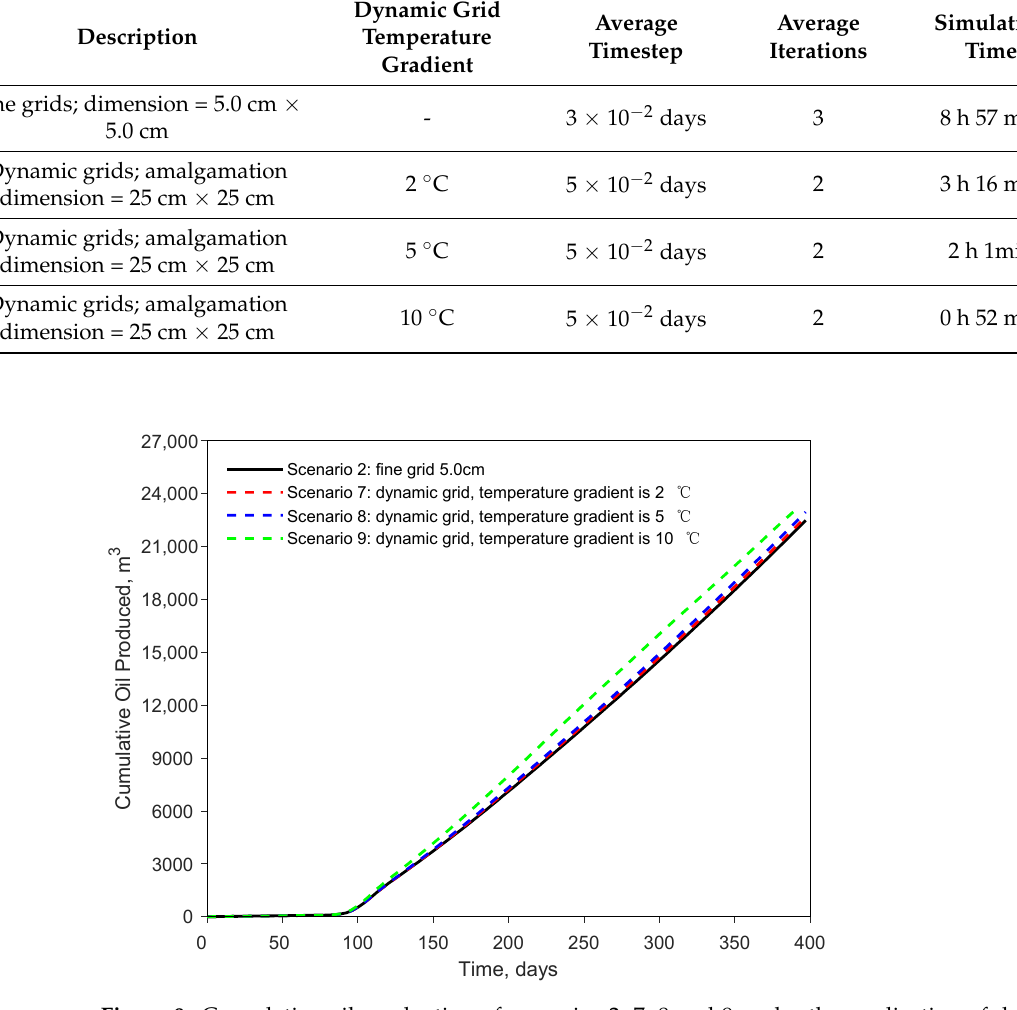
Figure 9. Cumulative oil production of scenarios 2, 7, 8 and 9 under the application of dynamic gridding.